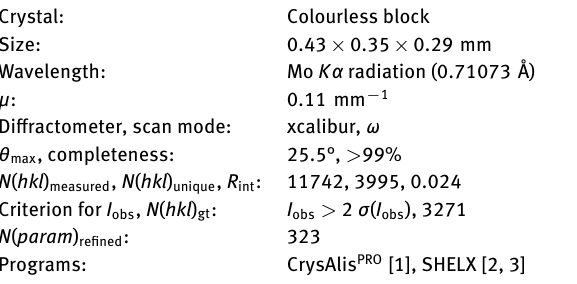
Table 1: Data collection and